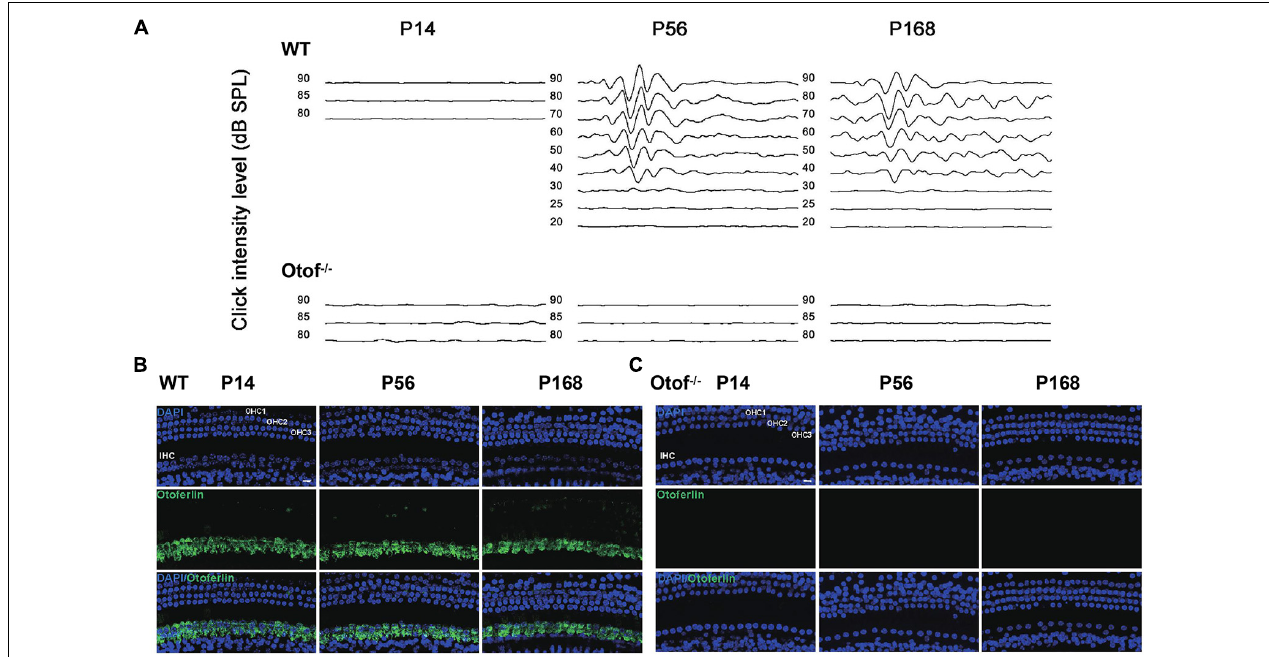
FIGURE 1 | Complete elimination of hearing input presented before and after hearing onset in Otof − / − mice. (A) No visible ABR waveforms (click) were found at P14, P56, and P168 in Otof − / − mice, respectively; also, no ABR waveforms (click) were seen at P14 in WT mice. However, there are normal ABR waveforms (click) at P56 and P168 in WT mice. (B) Normal otoferlin expressions were seen in cochlear inner hair cells (IHCs) at P14, P56, and P168 in WT mice (green). (C) No positive immunostaining signals were found at P14, P56, and P168 in Otof − / − mice. Bar = 10 µ m; WT, wild-type mice; Otof − / − , otoferlin knockout mice; dB, decibel.